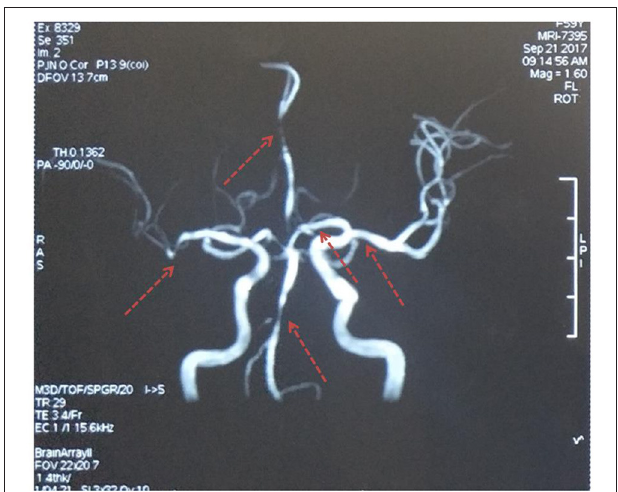
FIGURE 2 | Magnetic resonance angiography. Multiple stenoses in the bilateral middle cerebral arteries, anterior cerebral artery, and basilar artery. The red arrows indicate